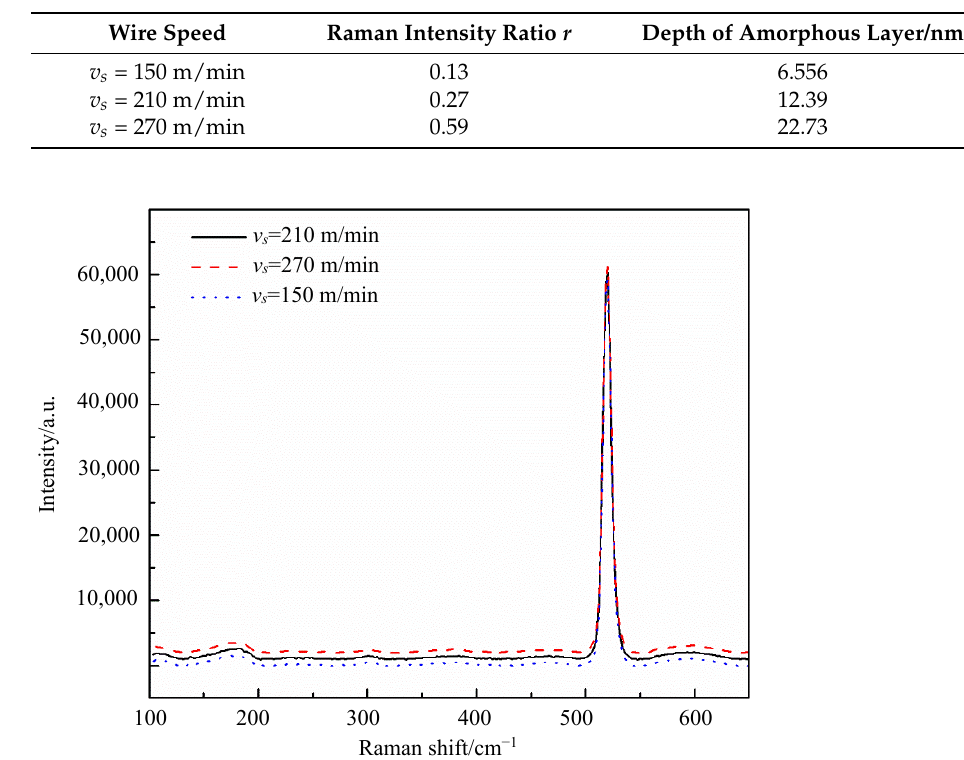
Table 2. The ratio r and depth of amorphous silicon layer for three kinds of sawn silicon wafers.